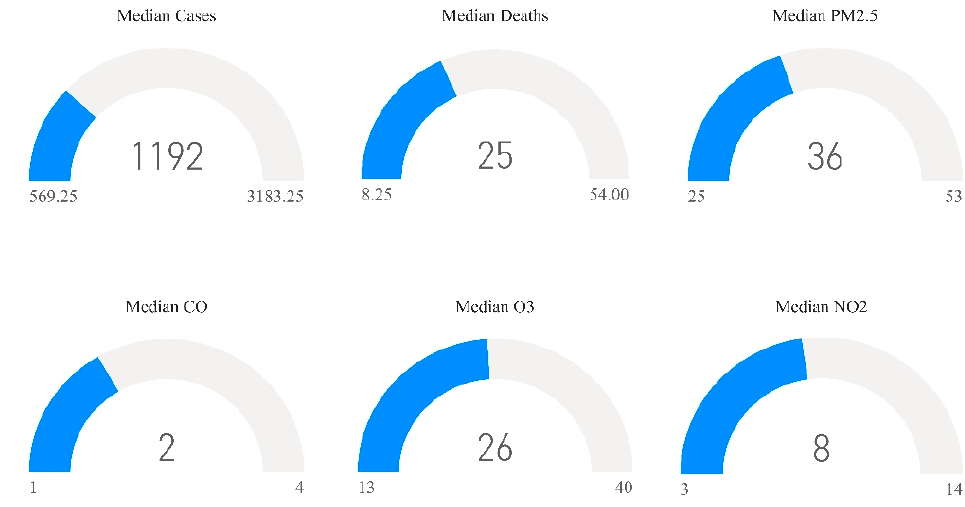
Figure 2. Median (25th–75th) quartiles of study parameters.